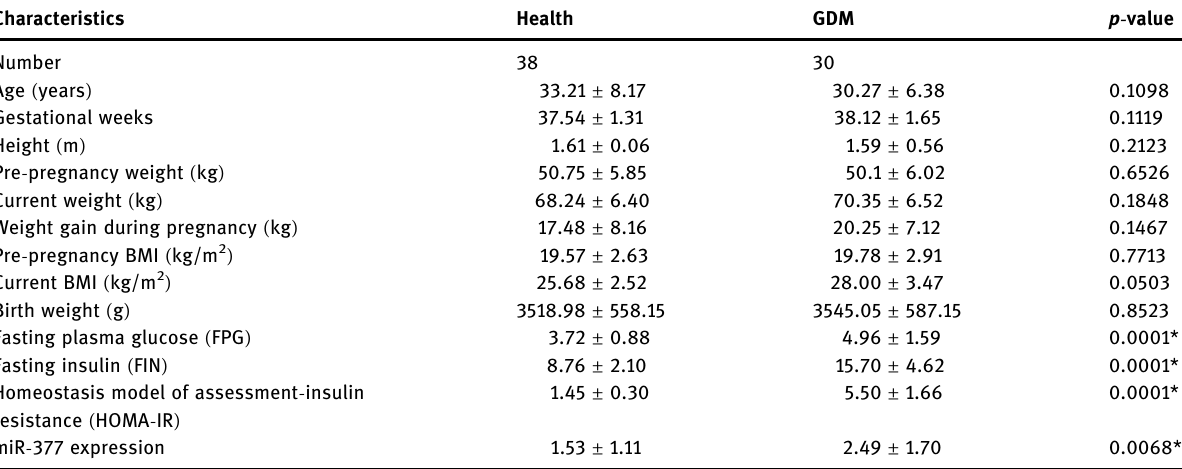
Table 1: The expression of FoxO1 in placenta and omental adipose tissue of GDM